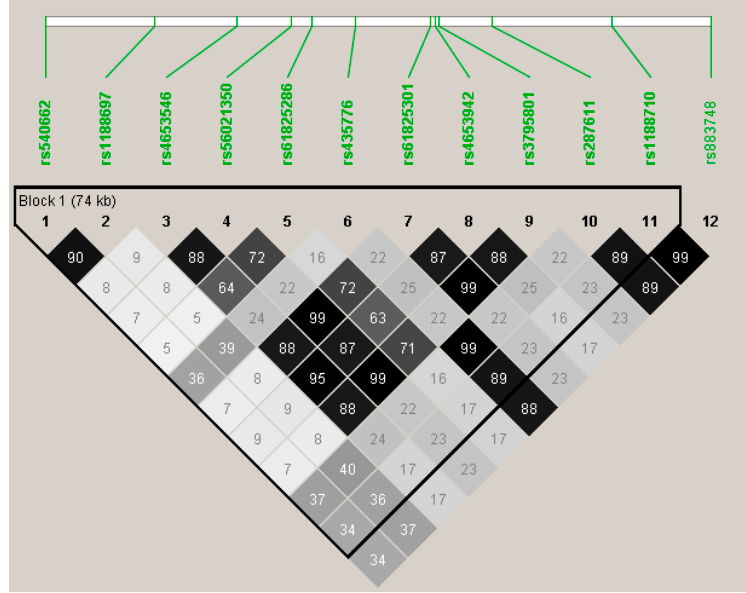
Figure 2. OBSCN variants, p < 0.05, linkage disequilibrium plot. Three missense variants were significant at OBSCN following Bonferroni correction for testing 55 variants at this locus: rs56021350/Thr4399Met, rs4653942/Arg4534His and rs1188710/Gln5891Glu, ( p = 0.0009, 0.0007 and 0.0008 respectively). rs56021350 and rs4653942 are in linkage disequilibrium, but clearly, rs1188710 is not correlated with these variants, suggesting multiple independent variants at this locus.